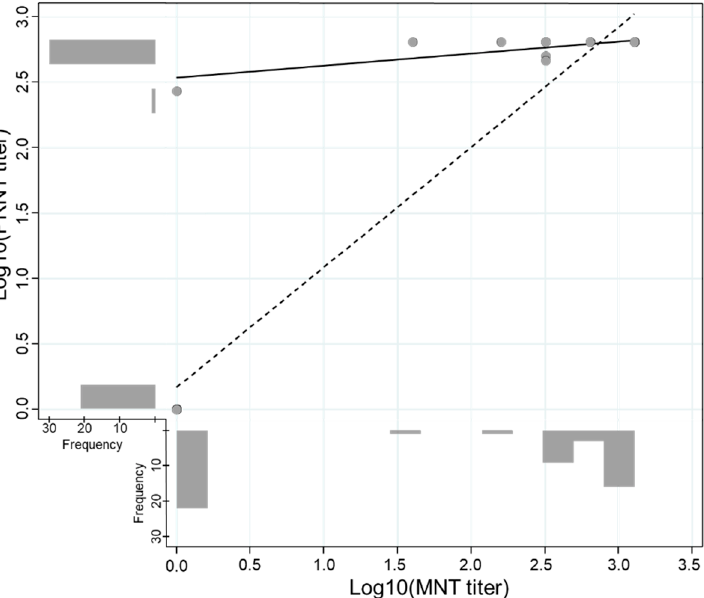
Figure 3. Correlation of log-transformed titers of the Plaque Reduction Neutralization (PRNT) and Microneutralization (MNT) Tests. The scatter plot illustrates the correlation between the log-transformed PRNT and MNT titers. The correlation including and excluding negative results is represented by the dashed line ( n = 31, Spearman’s Rho = 0.419, p -value = 0.019) and solid line ( n = 51, Spearman’s Rho = 0.901, p -value < 0.001), respectively.